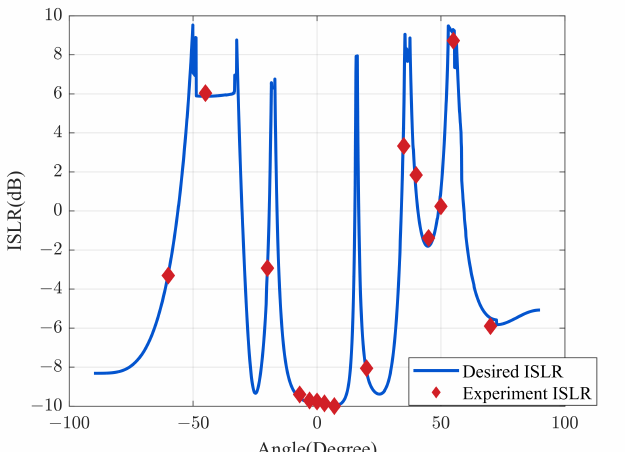
Figure 14. Comparison of the desired ISLR (blue) and the experimental ISLR